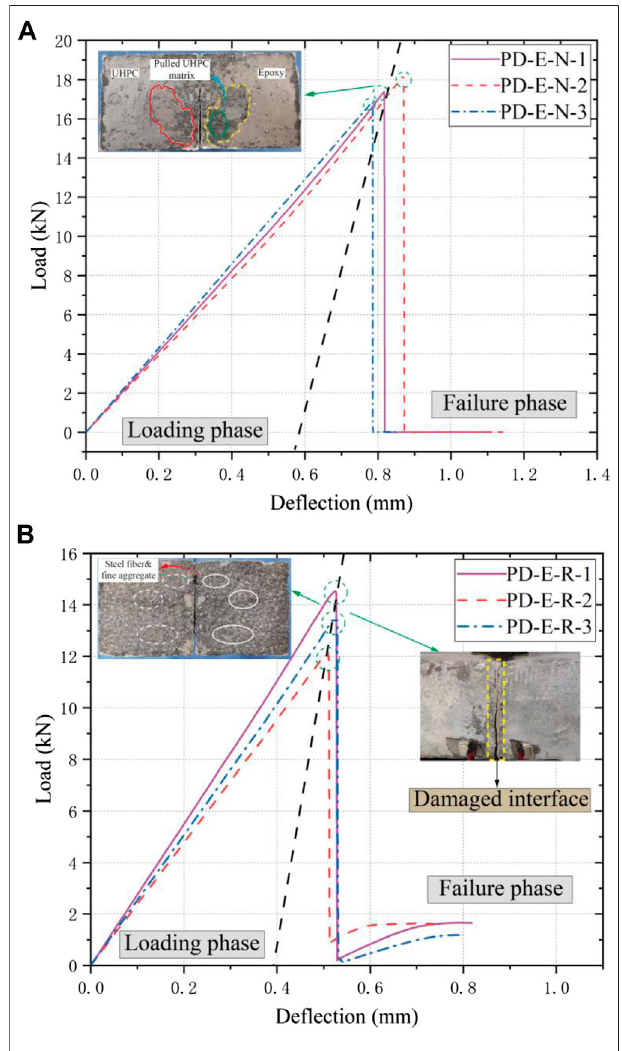
FIGURE 7 | Load-de fl ection curves of all specimens. (A) PD-E-N specimens. (B) PD-E-R specimens. (C) PD-E-G specimens. (D) PD-E-K